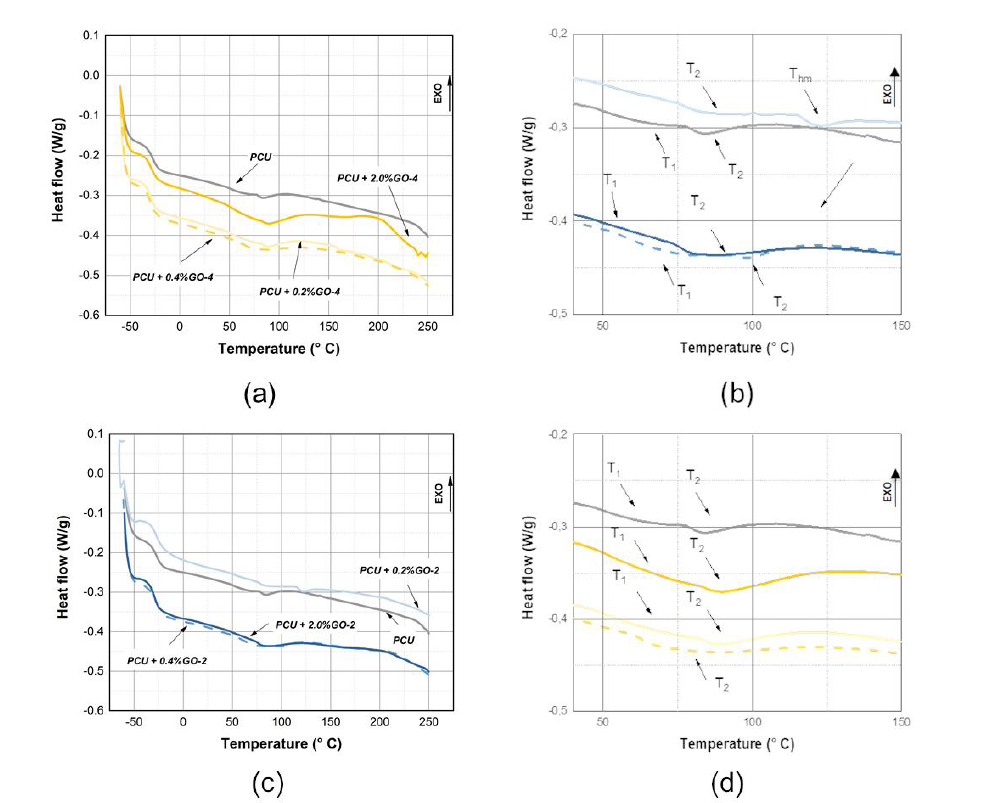
Figure 9. DSC curves for neat PCU and its nanocomposites using GO-2: (a) for all temperature range and (b) specific range; and GO-4 (c) for all temperature range and (d) specific